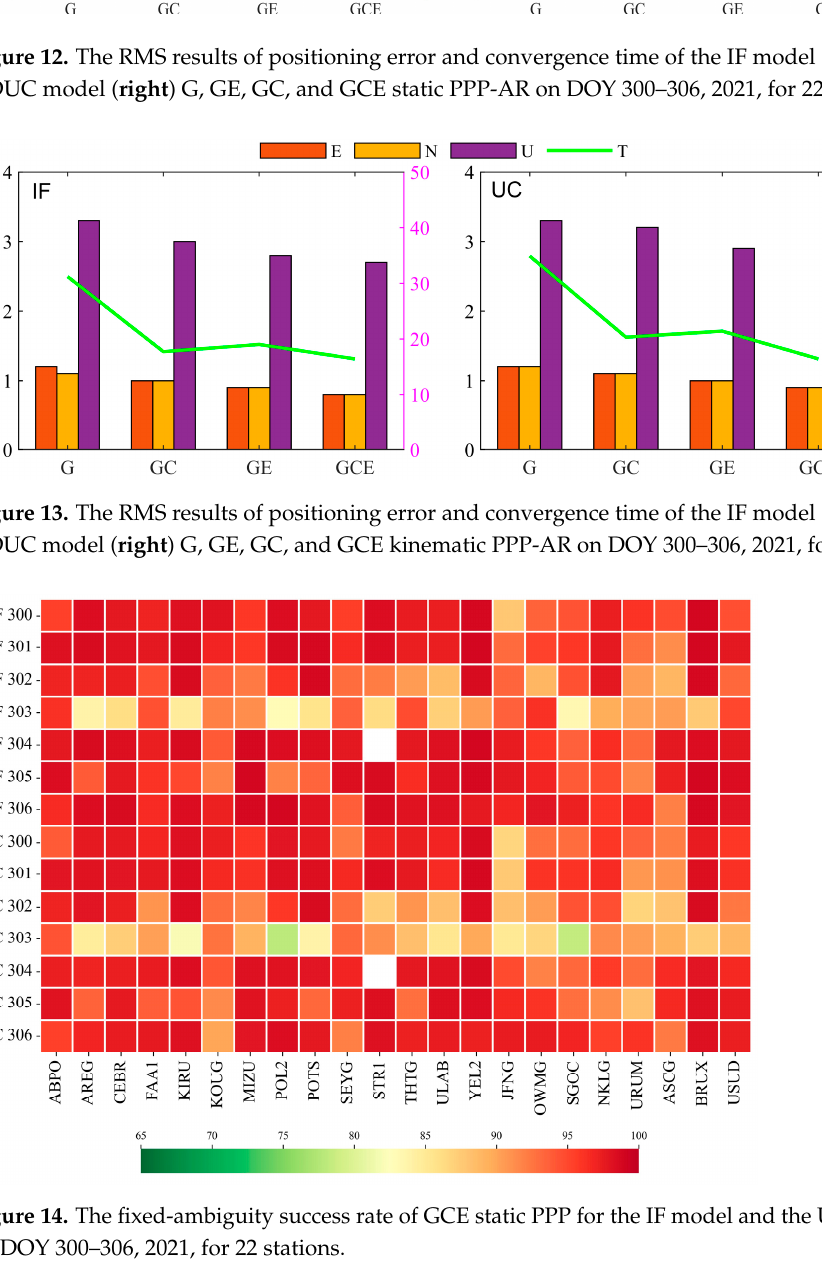
Figure 15. The fixed-ambiguity success rate of GCE kinematic PPP for the IF model and the UDUC model on DOY 300–306, 2021, for 22 stations. For quantitative analysis, the average positioning error and convergence time of the PPP and PPP-AR for different systems under the IF and UDUC models for both static and kinematic modes are given in Tables 5 and 6, respectively. Table 5. The RMS results of position differences and convergence time of the IF model (left) and the UDUC model (right) G, GC, GE, and GCE static float/fixed PPP on DOY 300-306, 2021, for 22 sta- tions.